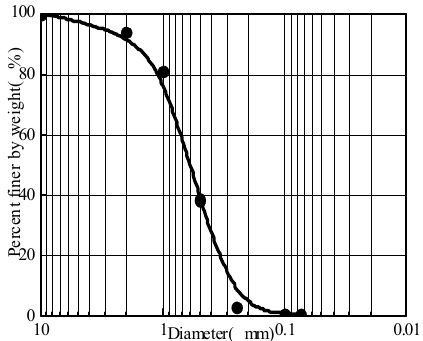
Figure 1. Shield construction disturbance to the mechanical properties of coastal sand.